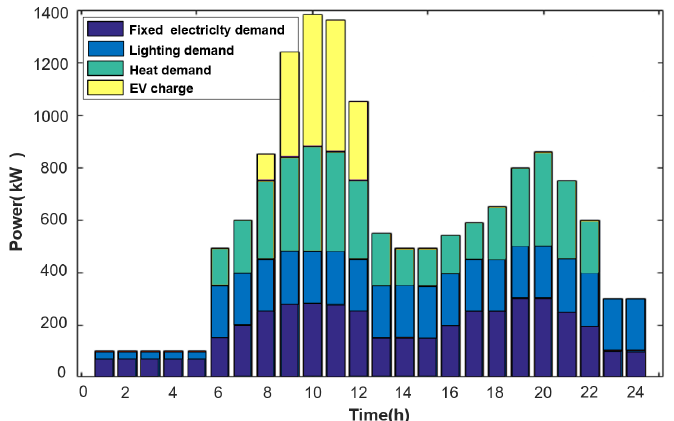
Figure 9. Power consumption in winter for commercial users.